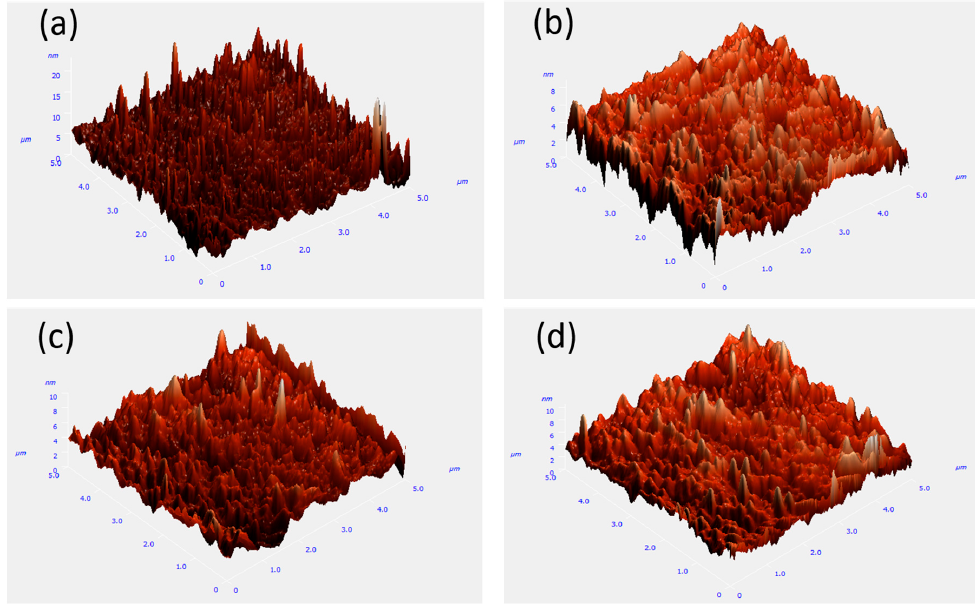
Figure 3. Atomic force microscope (AFM) images of the IGO films sputtered under ( a ) 0%; ( b ) 5%; ( c ) 10%; and ( d ) 20%.